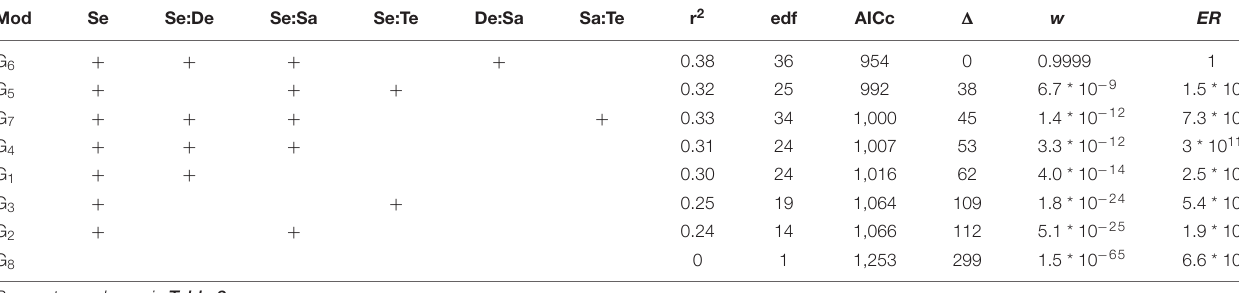
TABLE 3 | Summary of information-criteria-based model selection for the Shannon diversity (H’).